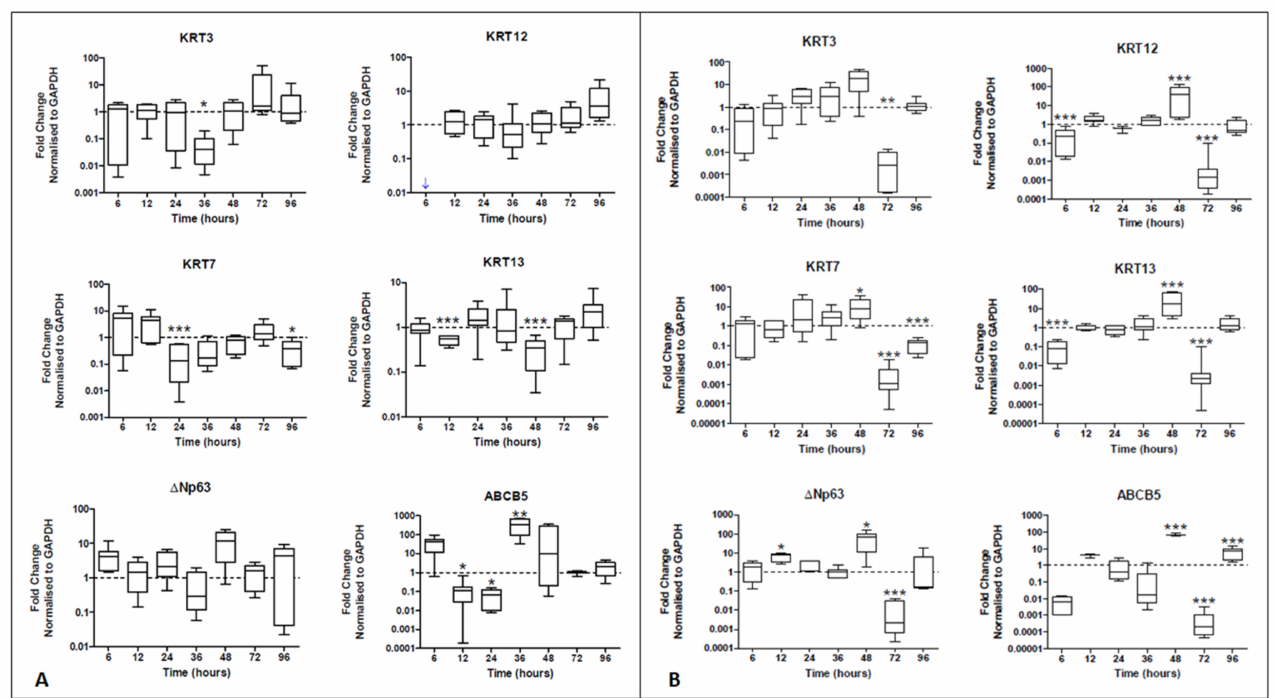
Figure 3. Real-time qPCR data showing the expression of epithelial cell markers by ( A ) HCjE-Gi and ( B ) hTCEpi cells when cultured in the medium containing hTCEpi-derived and HCjE-Gi-derived exosomes compared to the cells cultured in medium containing HCjE-Gi-derived and hTCEpi- derived exosomes, respectively. The data were collected and assessed over 96 h time period. (Data is represented as median ± 5–95 percentile, n ≥ 6, Mann–Whitney test, Bonferroni-corrected p -value, * p < 0.05, ** p < 0.01, *** p < 0.001). Dashed line represents the basal expression of the markers of interest when cells are cultured on their own respective exosomes-containing medium. Abbreviations used GAPDH: glyceraldehyde 3-phosphate dehydrogenase, KRT: keratin, ABCB5: ATP-binding cassette sub-family B member